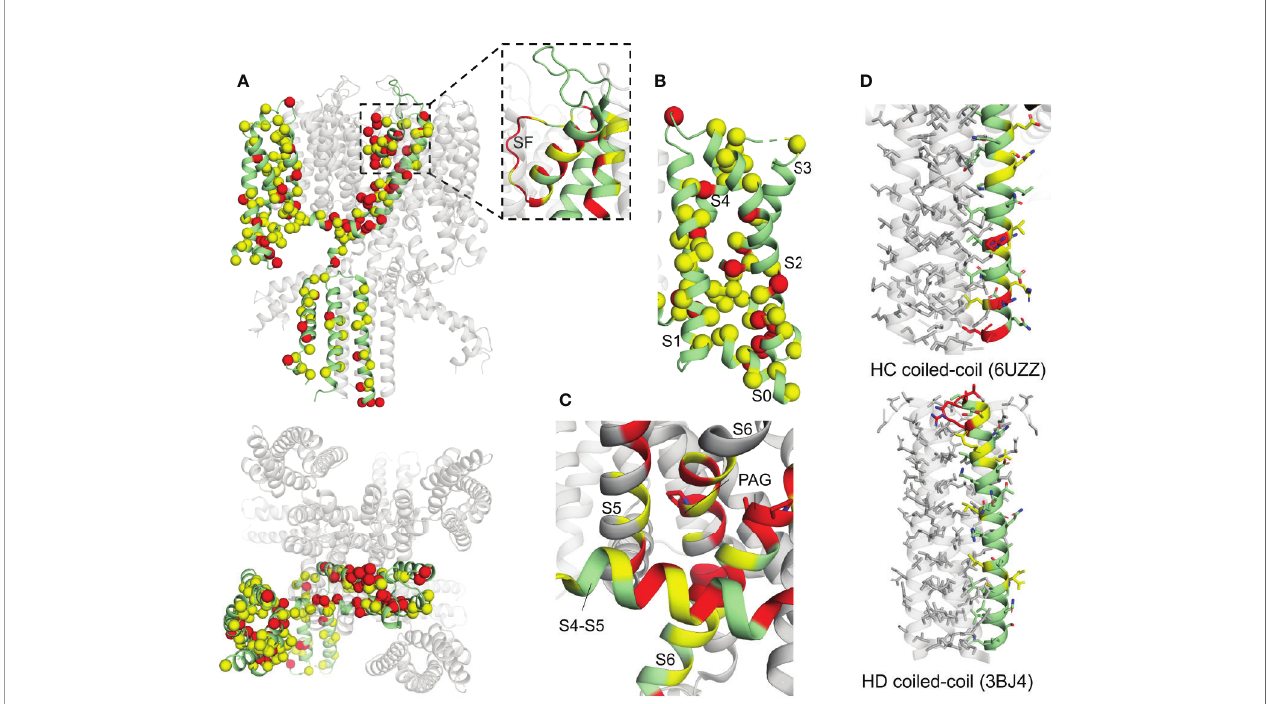
FIGURE 9 | Human KCNQ1 structure with deleterious mutation sites indicated. (A) Full KCNQ1 structure (PDB: 6UZZ) (Sun and Mackinnon, 2020). Yellow sites denote locations of a single deleterious mutation, while red indicates sites with multiple mutations identi fi ed. Spheres indicate C-alpha positions of mutation sites. Subunit with LQT1 mutations sites mapped is colored green. Inset: of SF and pore helix. (B) KCNQ1 VSD. (C) S4 – S5 linker (S4 – S5) interaction site close-up. One subunit is colored green and the others in gray, for clarity. The PAG motif (PAG) is indicated with sticks. (D) Top: HC coiled-coil domain. Bottom: HD coiled-coil domain (PDB: 3BJ4) (Wiener et al., 2008). Residue side chains are indicated with